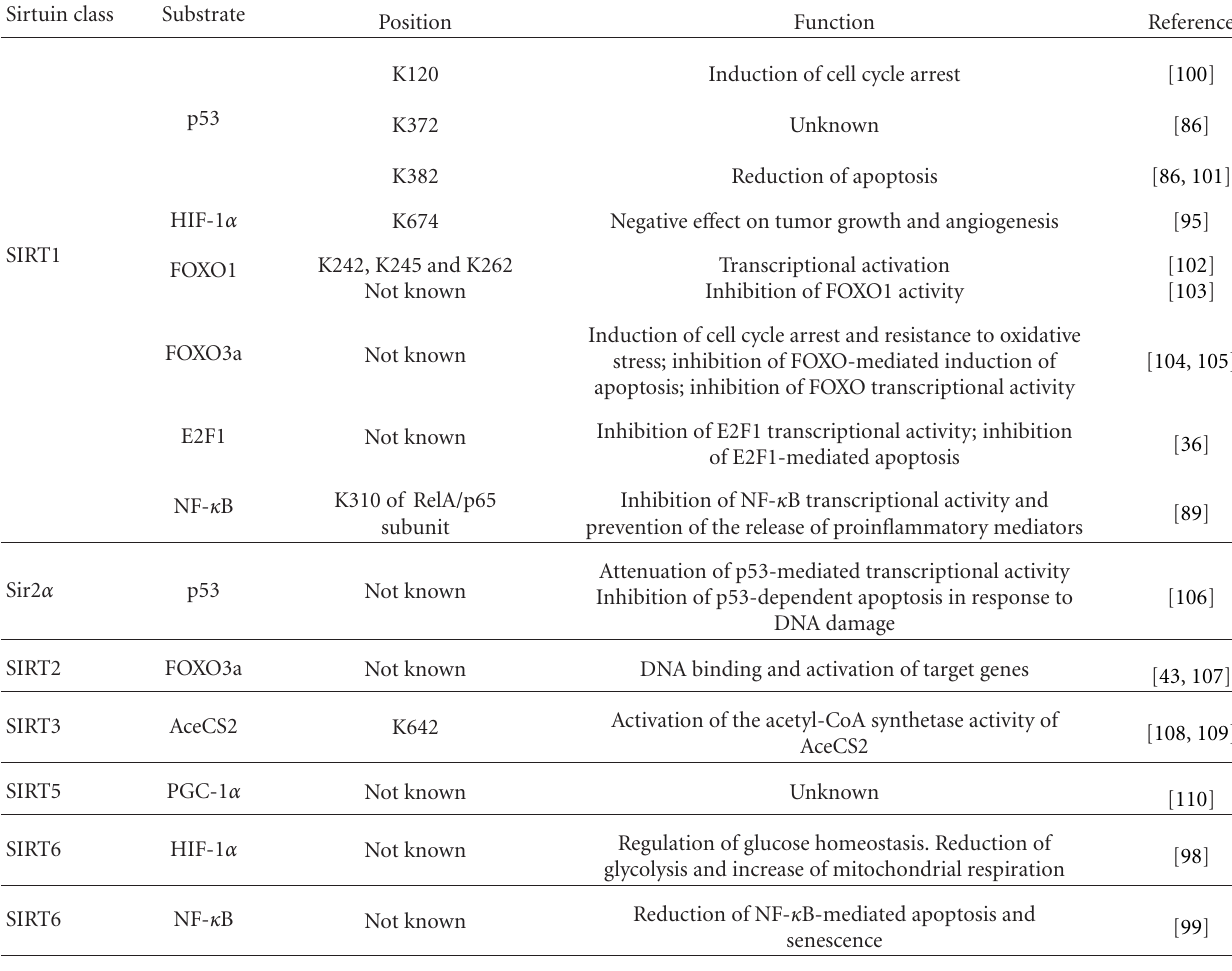
Table 1: Transcription factors associated with sirtuins.